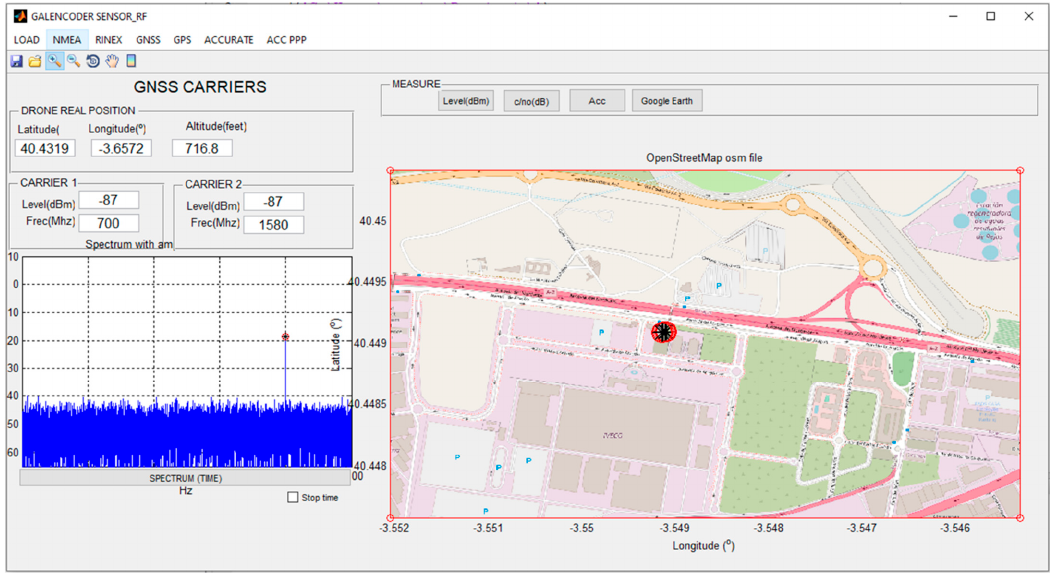
Figure 13. Map representation with mobile network signal values.